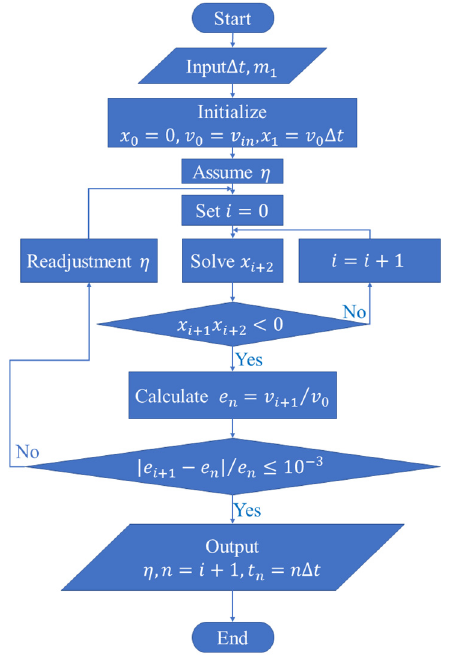
Figure 6. Flow chart for solving the damping coefficient.